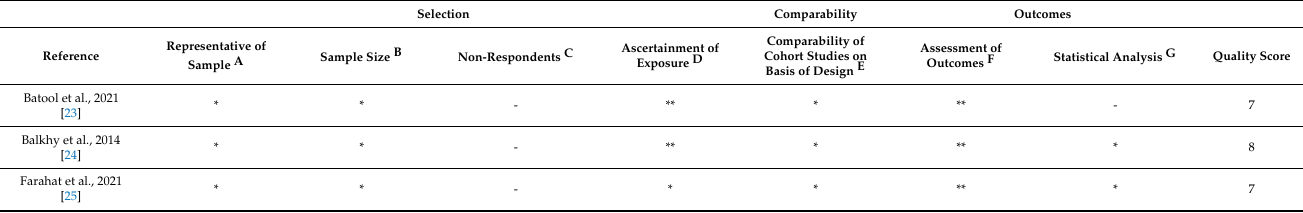
Table 3. Quality assessment of